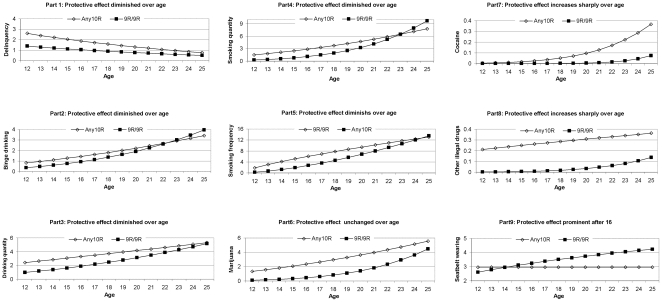
The protective effect of the DAT1*9R/9R genotype relative to the DAT1*Any10R genotype depends on age in adolescence and young adulthood: Parts 1–9.